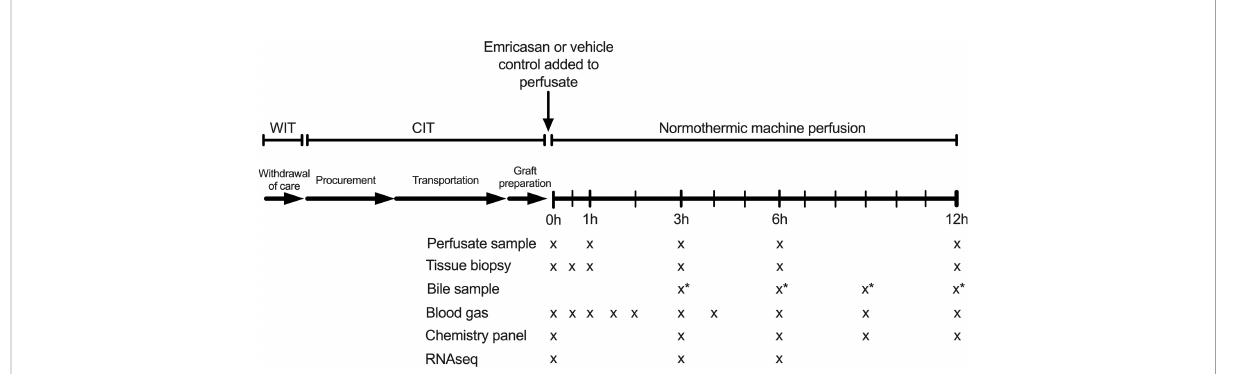
FIGURE 1 Liver preservation and NMP protocol. Emricasan (5mg/kg liver) or vehicle control (1mL DMSO) was added to the circulating perfusate immediately prior to connection of the liver to the NMP device. Serial tissue biopsies and perfusate samples were taken at indicated time points for subsequent analysis. * indicates a discordance between EM perfusions (bile samples taken at 3, 6, 9, and 12 hours) and control perfusions (bile samples taken at 4, 8, and 12 hours). NMP, normothermic machine perfusion; WIT, warm ischemic time; CIT, cold ischemic time; RNAseq, bulk RNA